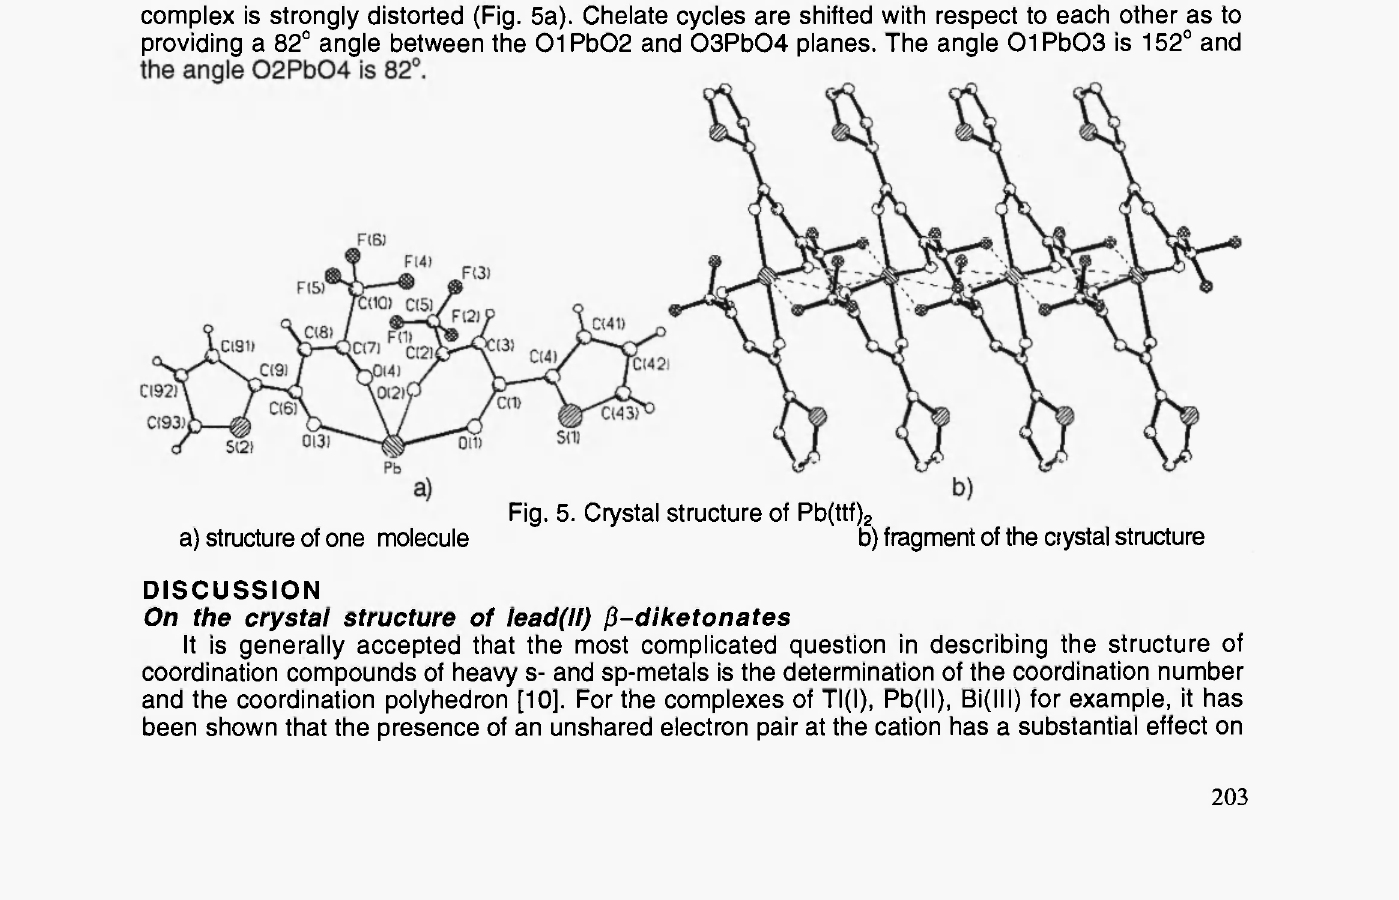
a) structure of one